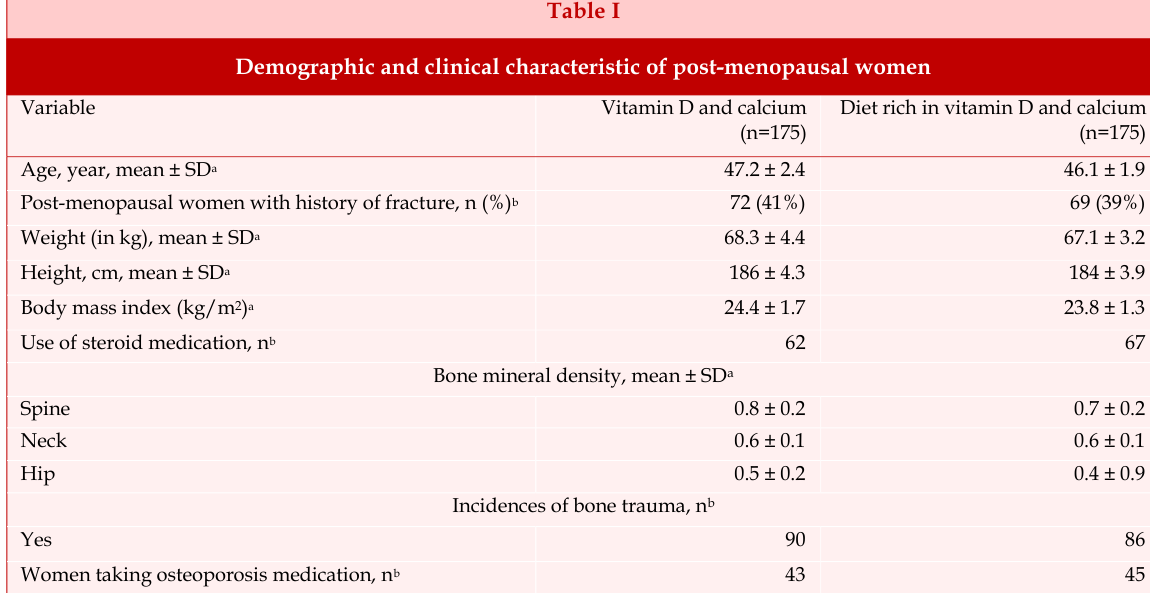
allocation ration of 1:1. Blood samples (5 mL) and urine